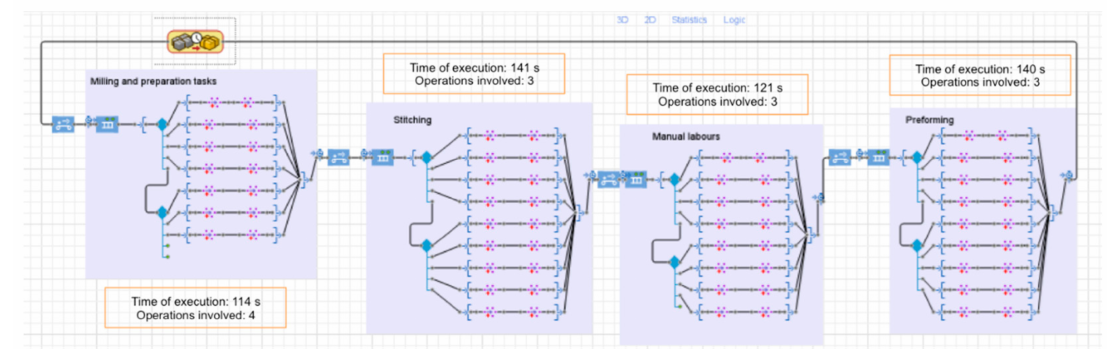
Figure 5. Logical blocks in ‘Rotary’ agent and configuration of the transition between the two phases. These blocks are associated with the direct-injection process.